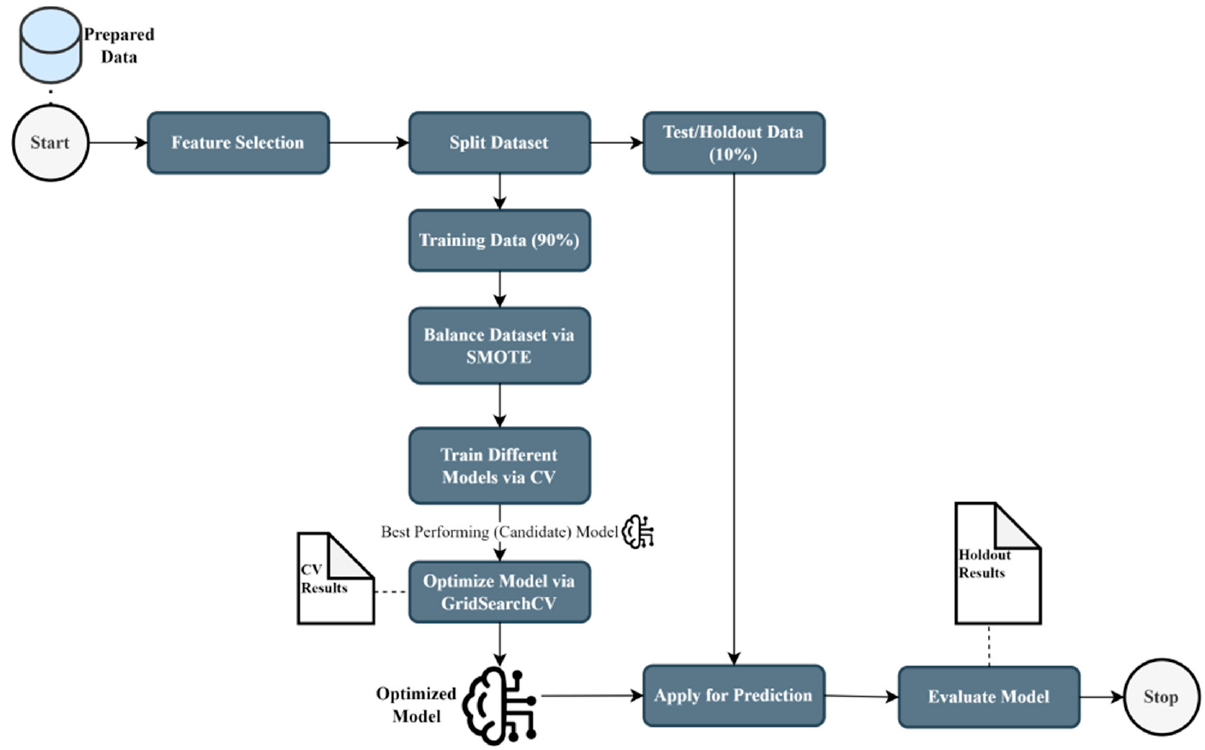
Figure 2. Modeling Setup.